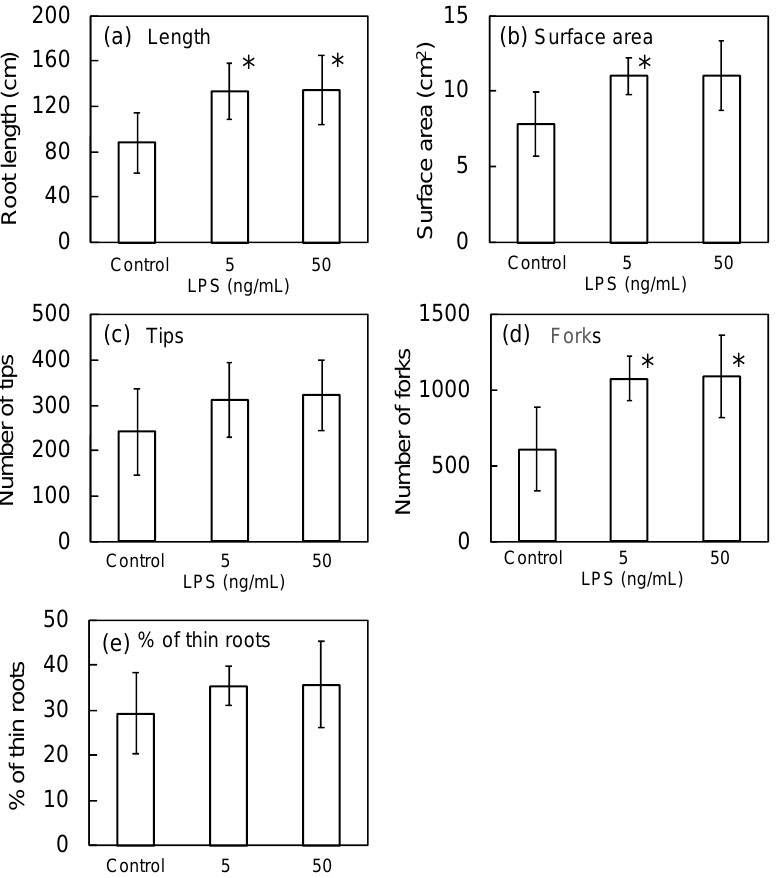
Figure 4. Effect of bio-priming by LPS of R. sphaeroides NBRC 12203 T on ( a ) root length, ( b ) surface area, ( c ) number of tips, ( d ) number of forks, and ( e ) % of thin (0.1 mm < diameter) roots. The rice seeds were bio-primed by LPS solution for 24 h, sown onto a cell pot and cultivated for 14 days. Data are means ± SD ( n = 5). An asterisk indicates the result that was significantly different (* p < 0.05) from the control.